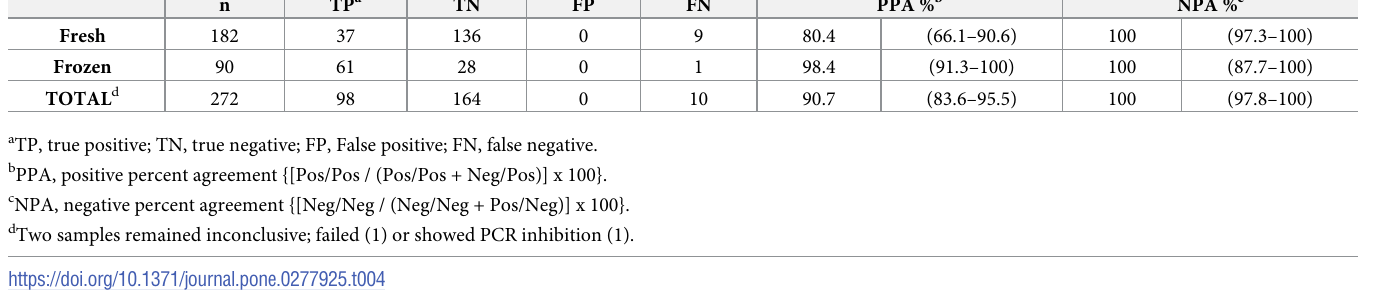
Table 4. Agreement of the GenomEra SARS-CoV-2 test with SOC RT-PCR tests from fresh and frozen samples.